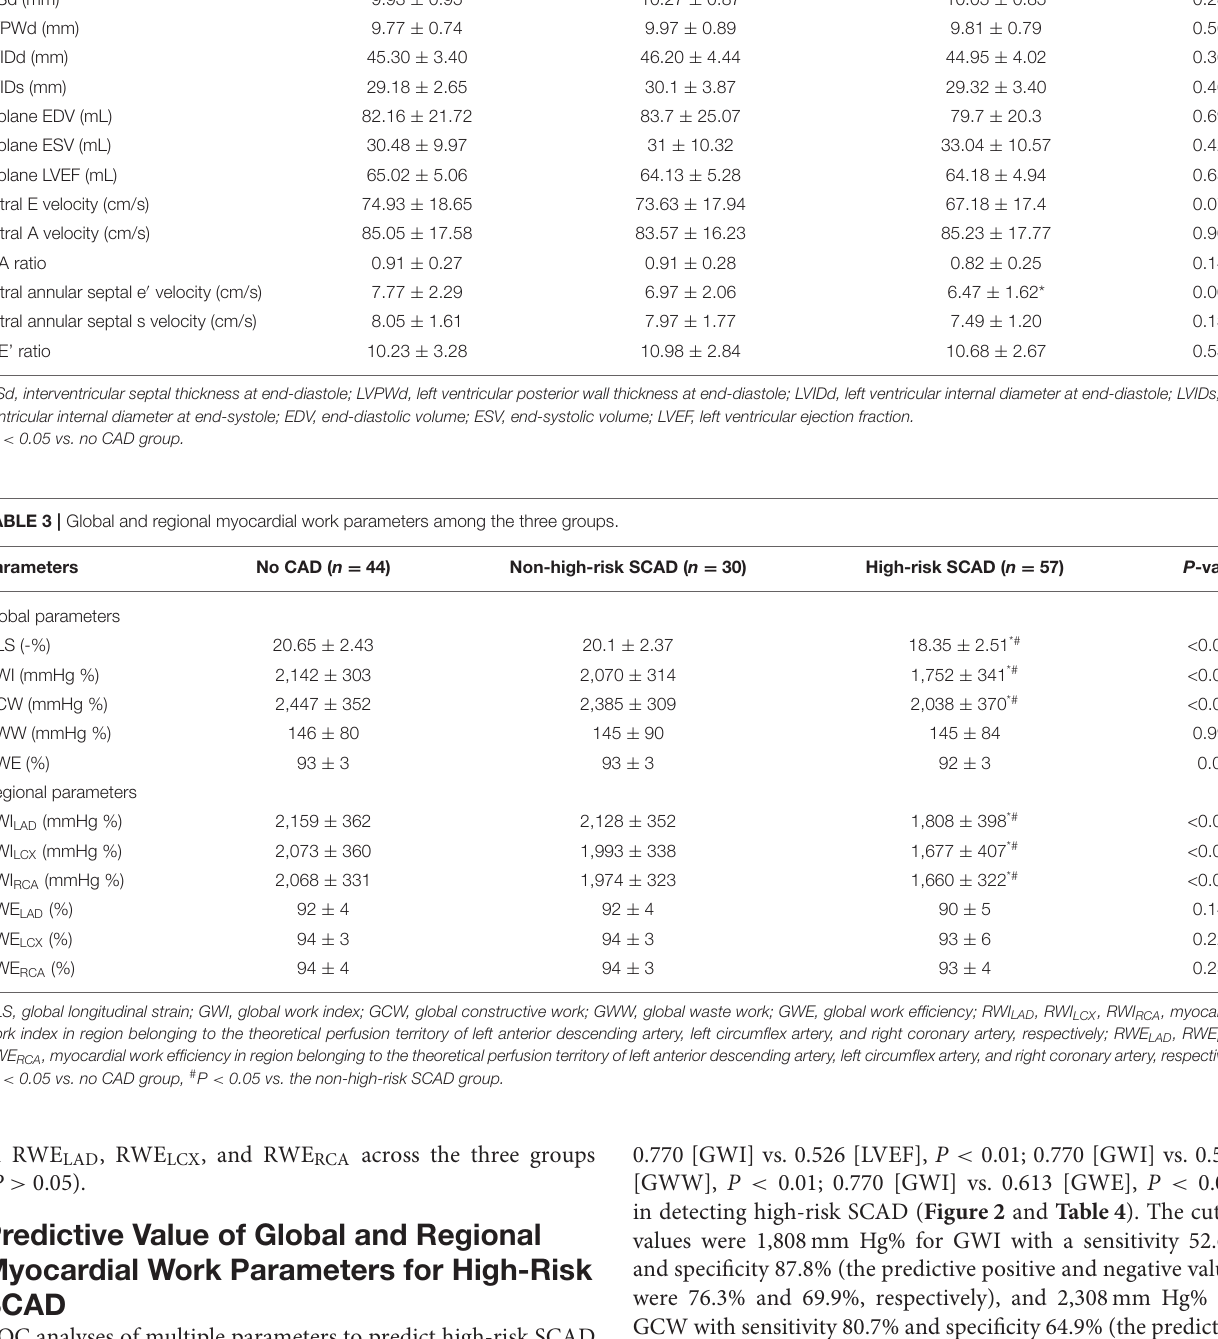
TABLE 2 | Conventional echocardiographic parameters in the study population. Parameters